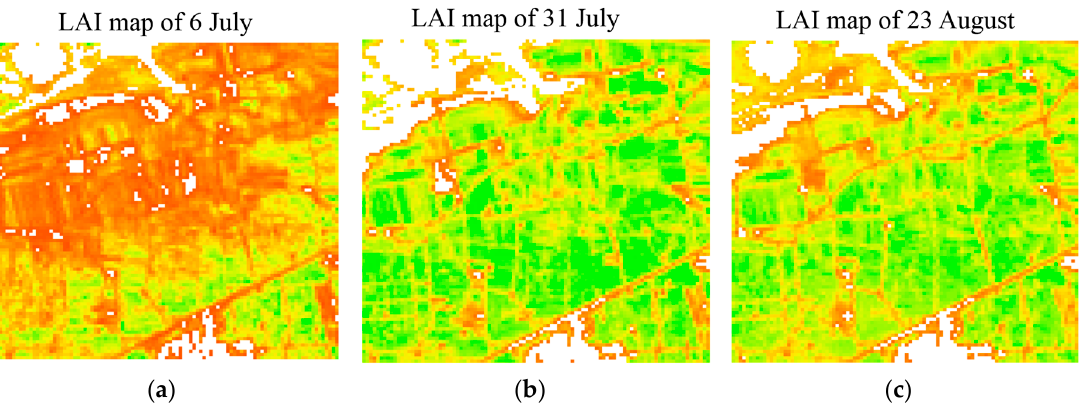
Figure 6. The estimated high-resolution LAI maps using the model based on PKB method for the limited dataset: ( a ) on 6 July; ( b ) 31 July; and ( c ) 23 August 2013.